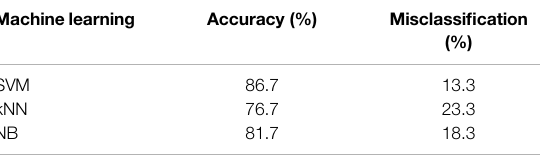
TABLE 3 | Machine learning classi fi er results. Machine learning